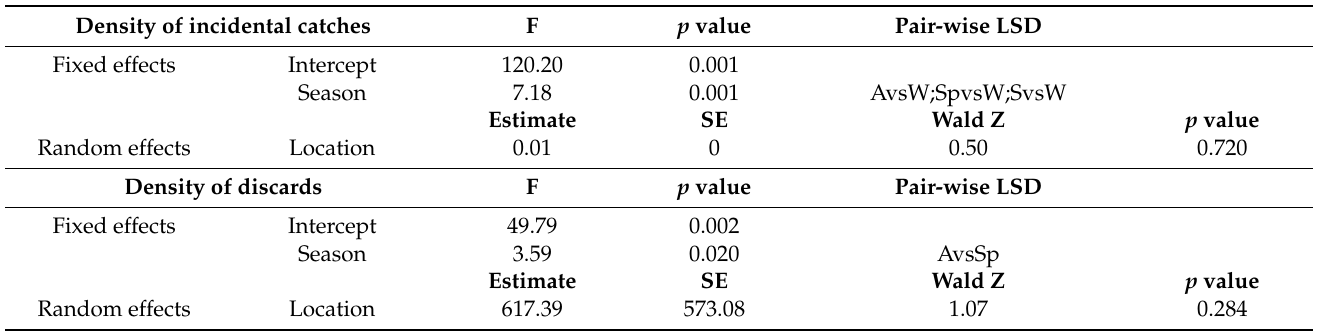
Table A2. Linear Mixed Model Effects results regarding species density with season (fixed factor) and location (random factor) as